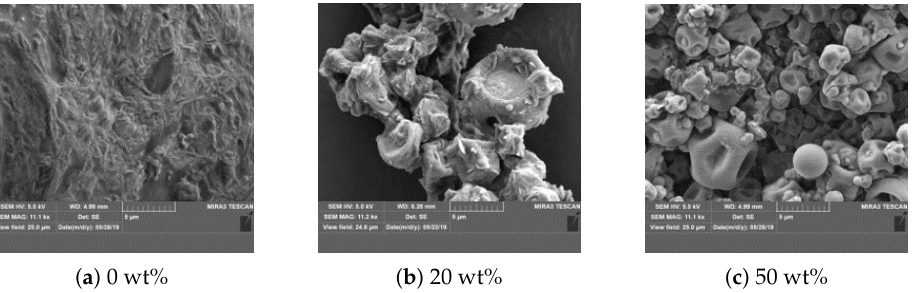
Figure A6. Effect of excipient loading on particle morphology. All formulations were spray dried from buffer at pH 5.5 containing no CaCl 2 . The percent values below each image are the weight percent concentration of medium-sized unfunctionalised silica excipient relative to the total dry mass of protein + excipient.